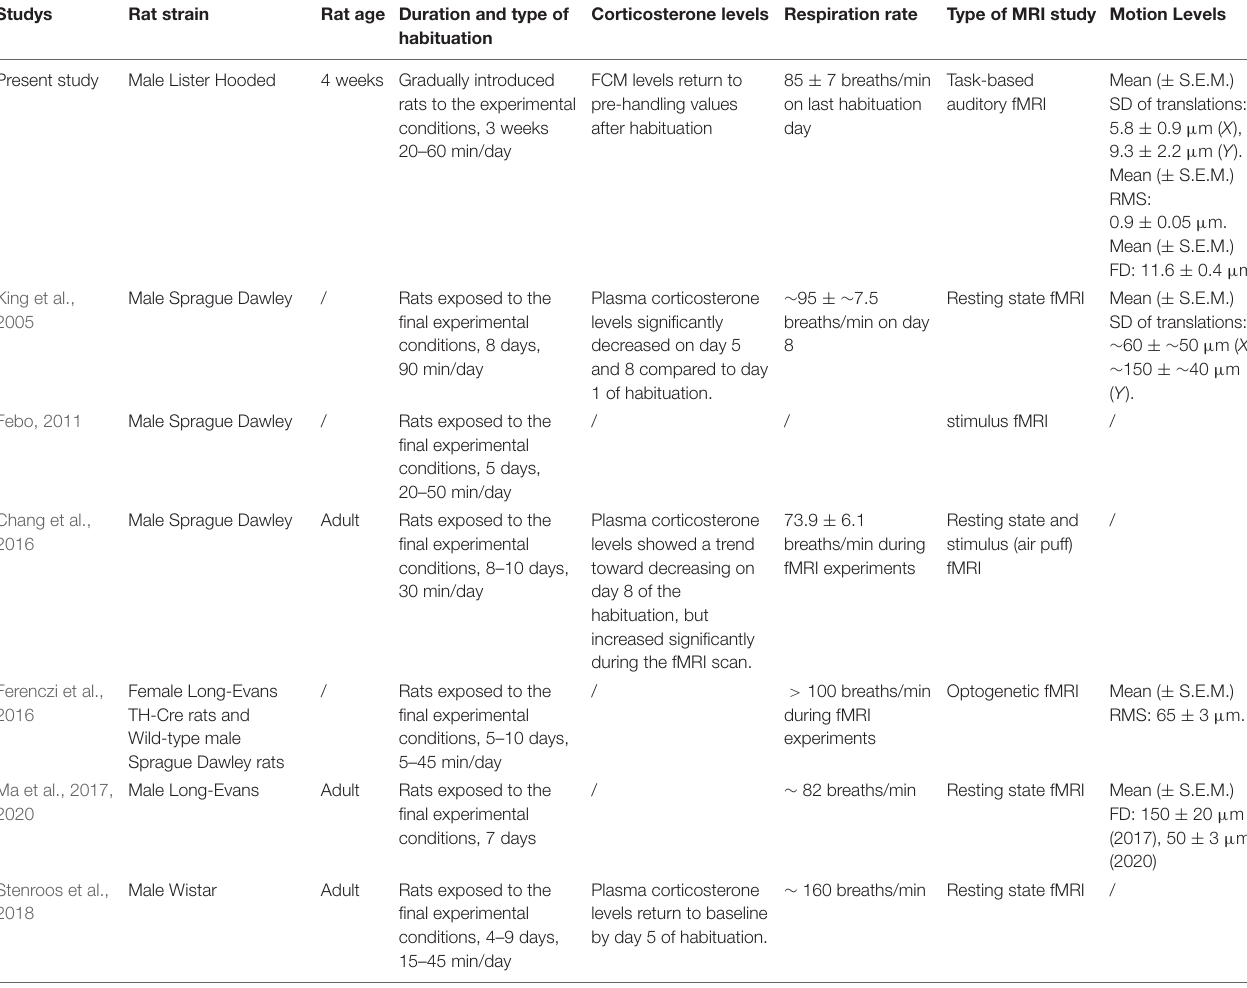
TABLE 2 | Comparison of the currently available awake-rat-functional magnetic resonance imaging (fMRI) strategies.